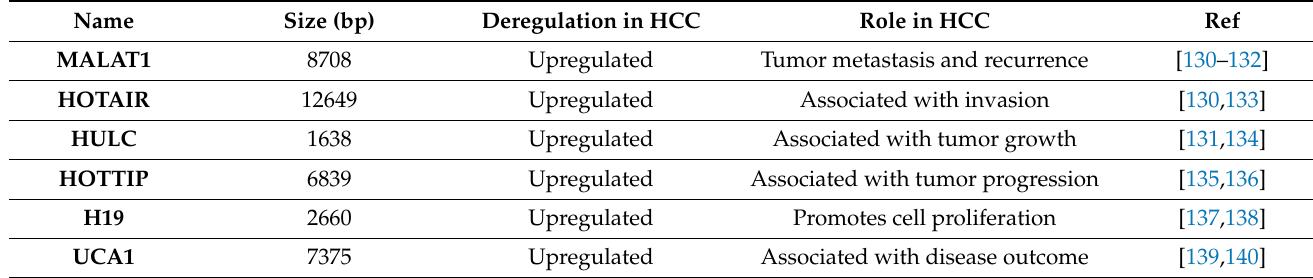
Figure 4. Non-coding RNAs regulating Notch Signaling. non-coding RNAs, including miRNAs and lncRNAs, target Notch signaling through mechanisms that directly regulate the expression of one of the Notch receptors (left panel) or by inhibition of proteins involved in the Notch signaling pathway (right panel). The red arrow indicates down-regulation while the blue one indicates up-regulation. Table 1. Important long noncoding RNA in hepatocellular carcinoma (HCC).